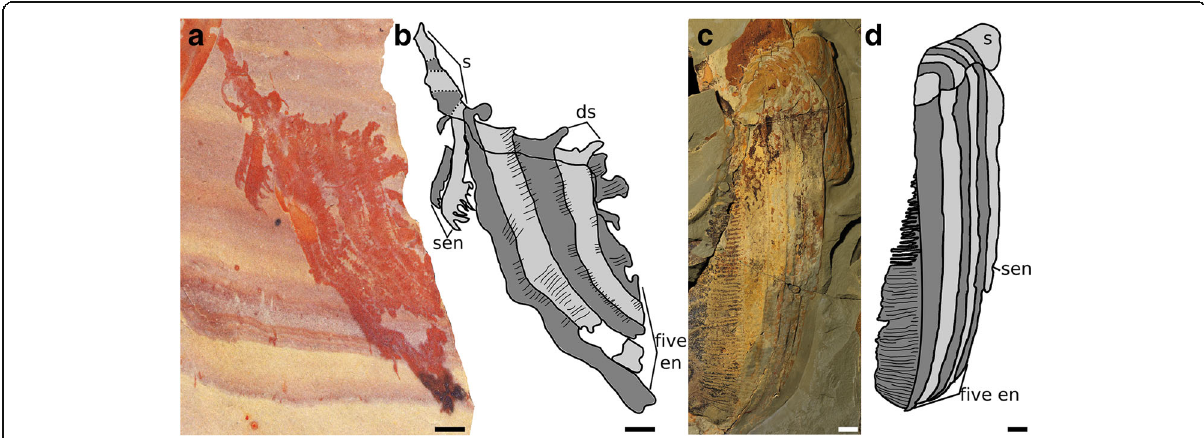
five en, five subequal endites on first five podomeres of distal articulated region; s, shaft; sen, shaft endite. Scale bars: a , b = 2 mm; c , d = 10 mm